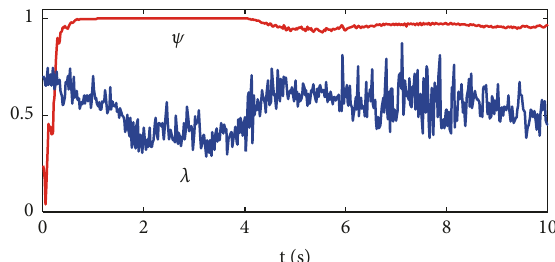
Figure7:Thepolarizationindexanddifferentiationindexunderthe control algorithm of [19].